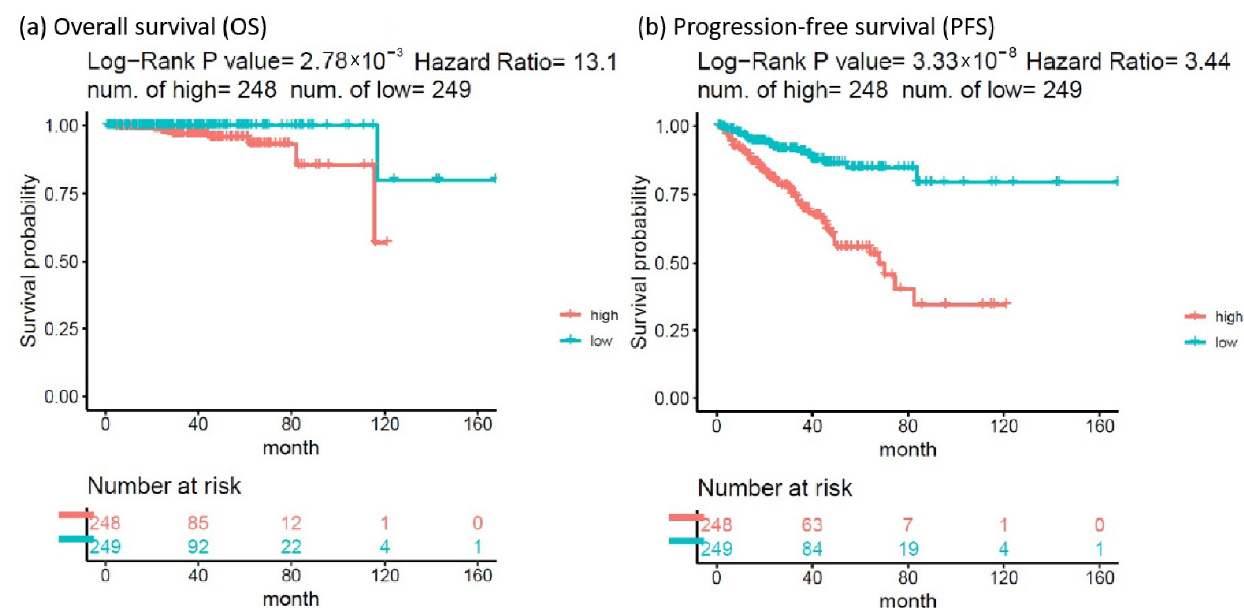
Figure 4. Kaplan–Meier analysis of ( a ) overall survival and ( b ) progression-free survival (PFS) in patients with higher vs. lower expression of the 4-gene panel ( DNTT , EXO1 , NEIL3 , and EME2 ). Table 2. Multivariate Cox regression analysis for OS and